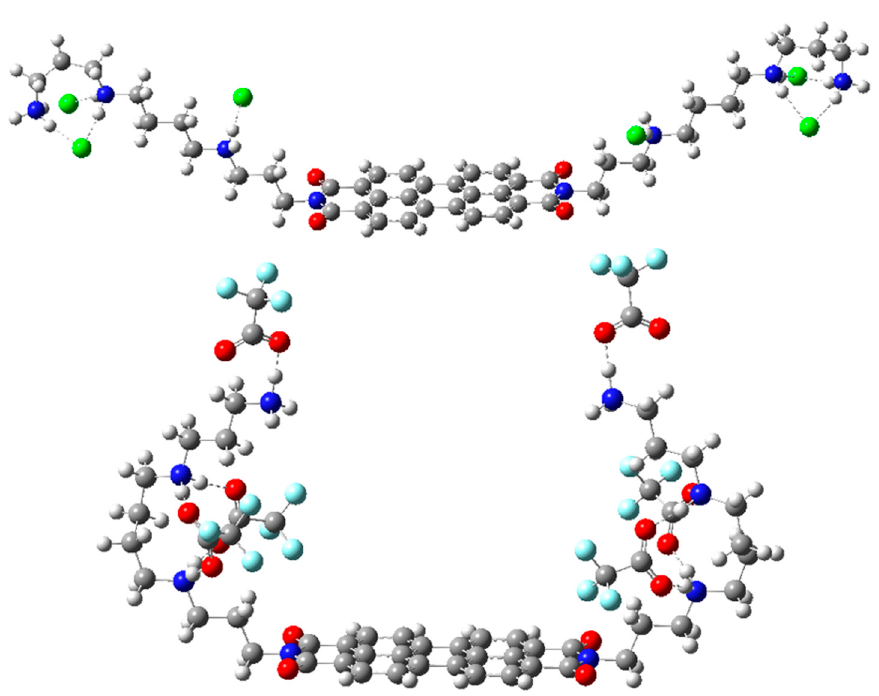
Figure 4. Energetically favored conformations for the hydrochloride 4 ( up ) and trifluoroacetate salt 5 ( down ).